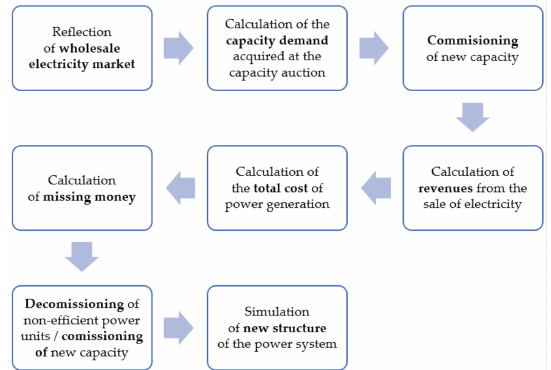
Figure 4. Calculation procedure under the CM